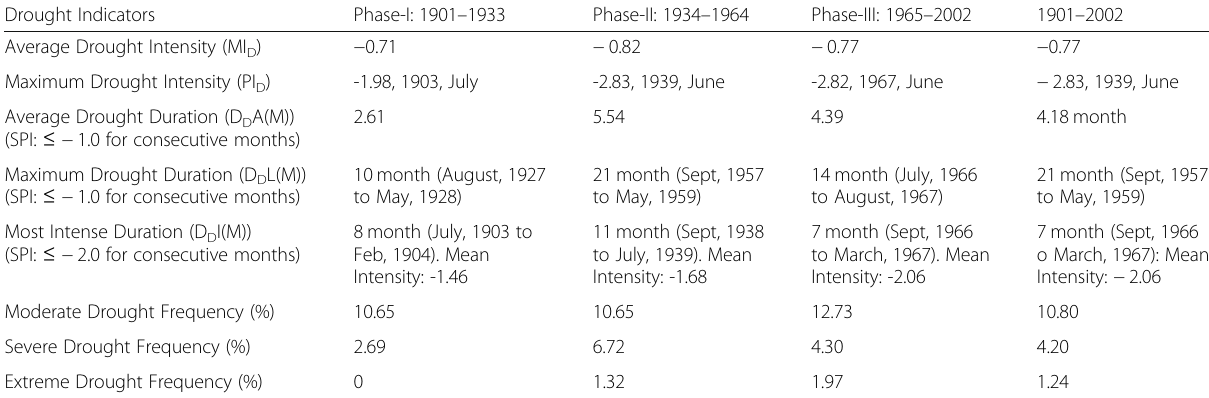
Table 7 Regional intensity, duration and frequency of drought events identified from SPI values at a 12-month scale for different periods in GWB